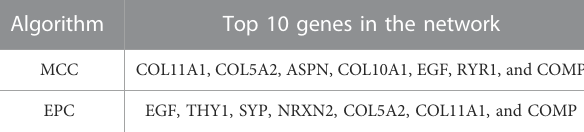
TABLE 2 Top 10 genes in the network using MCC and EPC algorithms. Algorithm Top 10 genes in the